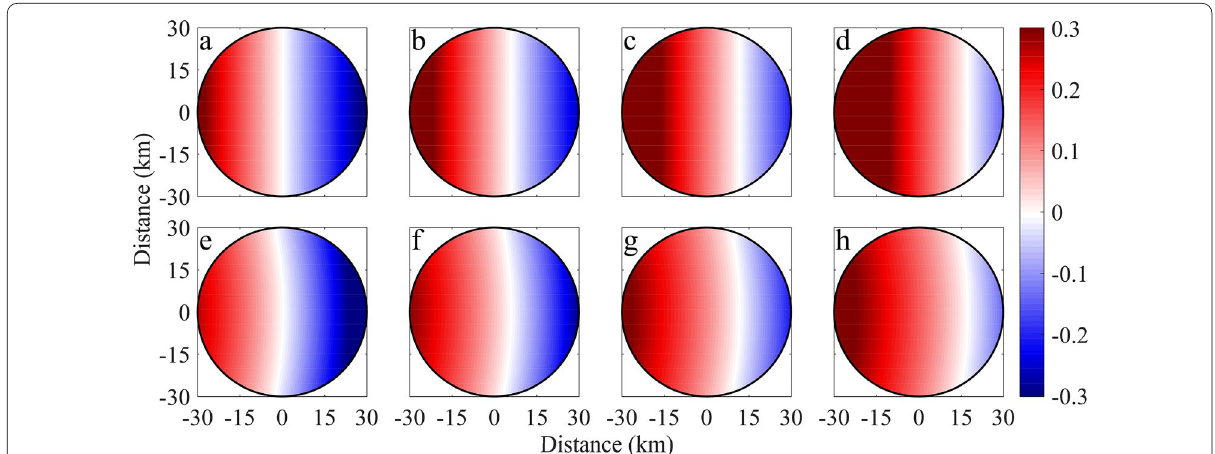
Fig. 2 Spatial distribution of power forced by absolute wind stress and relative wind stress on an idealized eddy. a – d For absolute wind stress, e – h for relative wind stress, ( a ) and ( e ) t